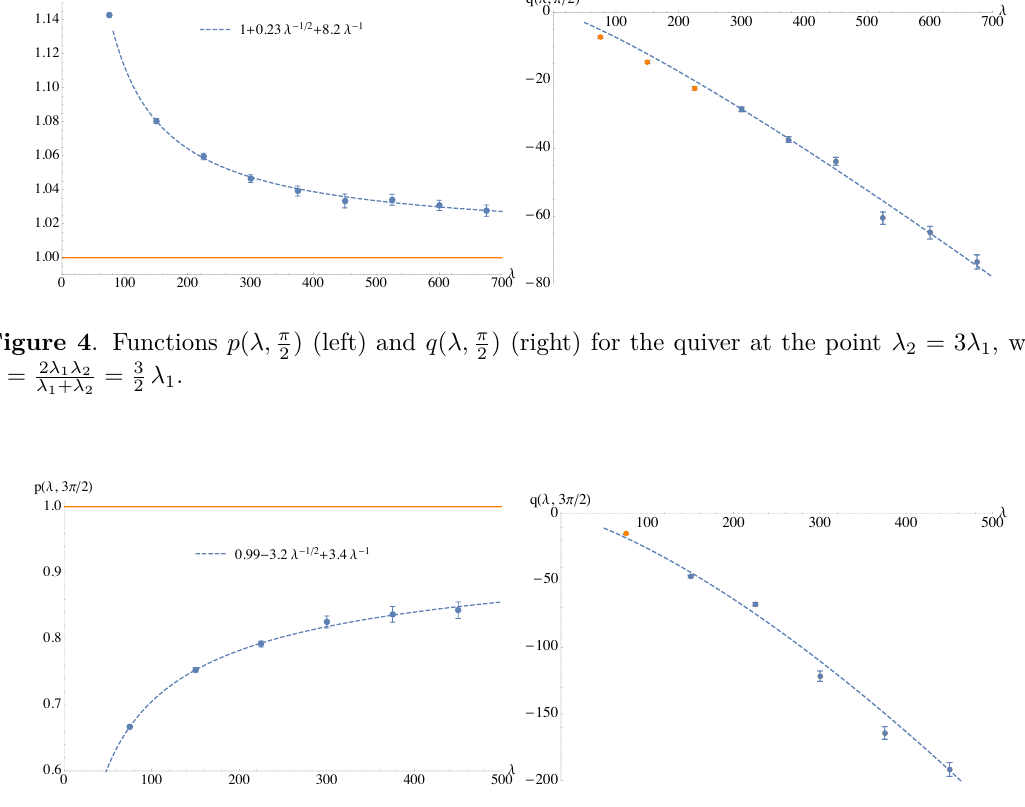
Figure 5 . Functions p ( λ, 3 π ) (left) and q ( λ, 3 π ) (right) for the quiver at the point λ 1 = 3 λ 2 , with 2 2 λ = 2 λ 1 λ 2 = 3 λ 2 . The angle θ = 3 π corresponds to the Wilson loop for the second SU( N ) λ 1 + λ 2 2 2